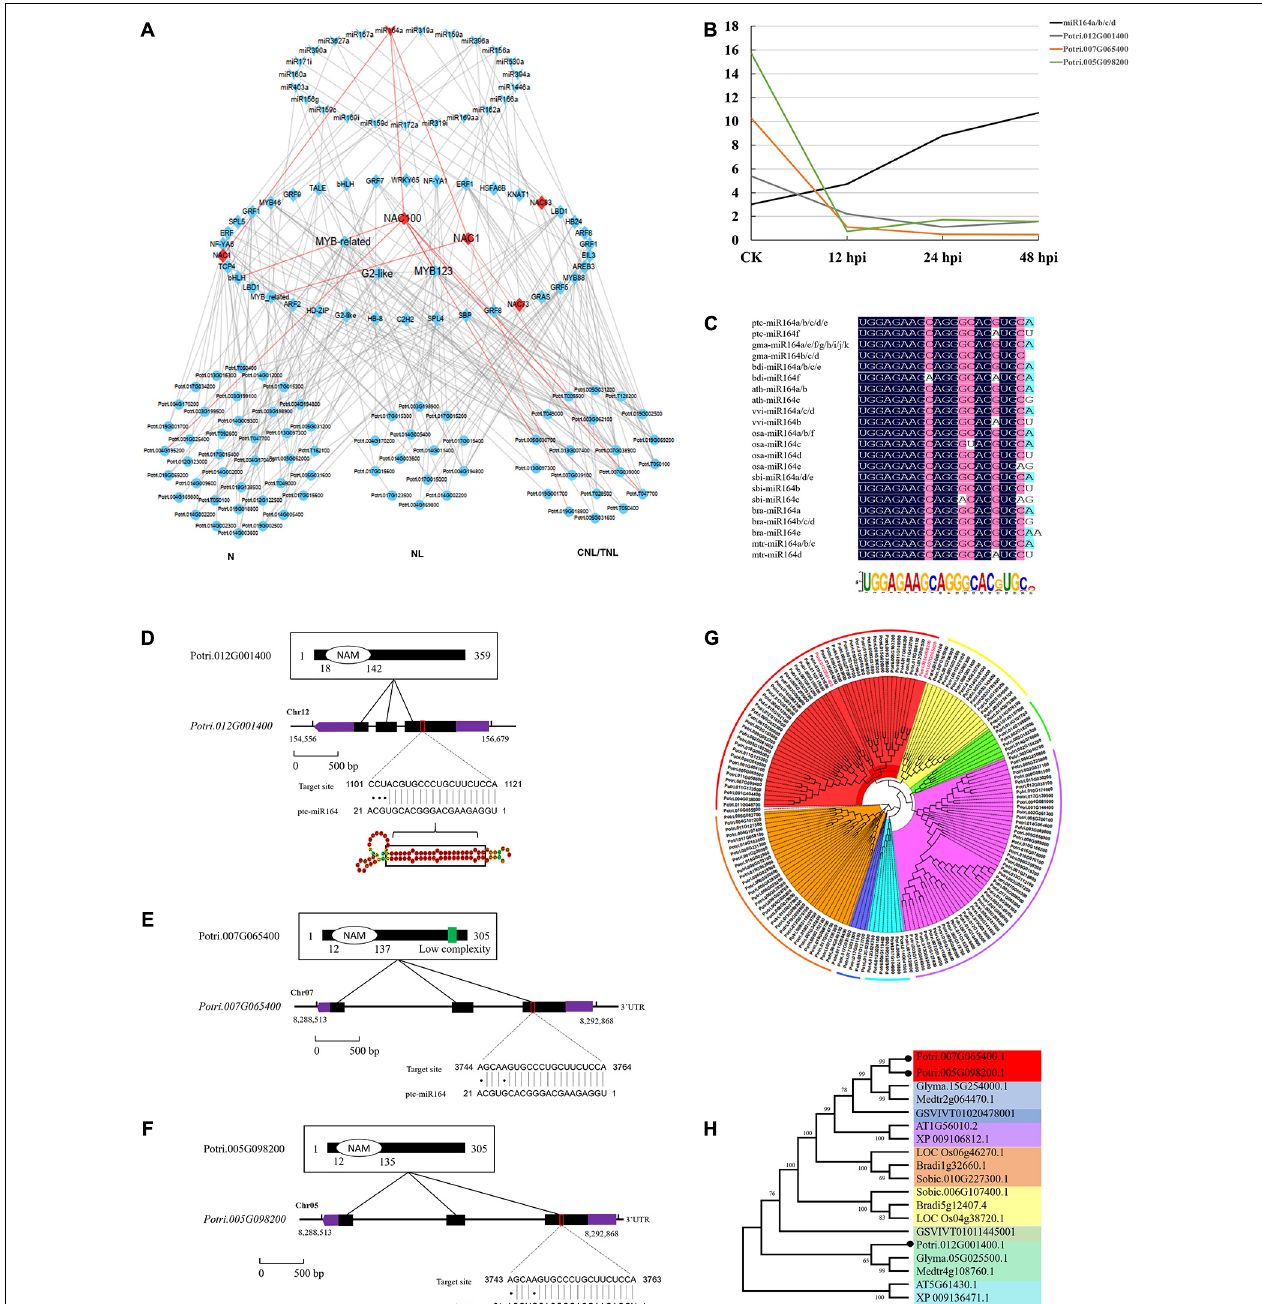
FIGURE 5 | Conserved miR164–NAC–mRNA regulatory network in response to fungi pathogen stress in Populus . (A) The three-layered gene regulatory network (GRN) was constructed with the backward elimination random forest (BWERF) algorithm. The nodes with red color highlighted the key regulatory transcription factors (TFs). (B) The expression value of miR164 and NAC1/100 genes. (C) Sequence logo view of the mature miR164 sequence. (D–F) Conserved domains of ptc-NAC1/100 protein sequence, gene structure of ptc-NAC1/100 , and predicted base-pairing interaction between ptc-miR164 and ptc-NAC1/100 . Exons are shown as black boxes and introns as lines . The 5 (cid:48) UTR and 3 (cid:48) UTR are shown as purple boxes. (G,H) Phylogenetic analysis of NAC targets of miR164 in Populus . Phylogenetic analysis of ptc-NAC1/NAC100 homologous genes in eight other plant